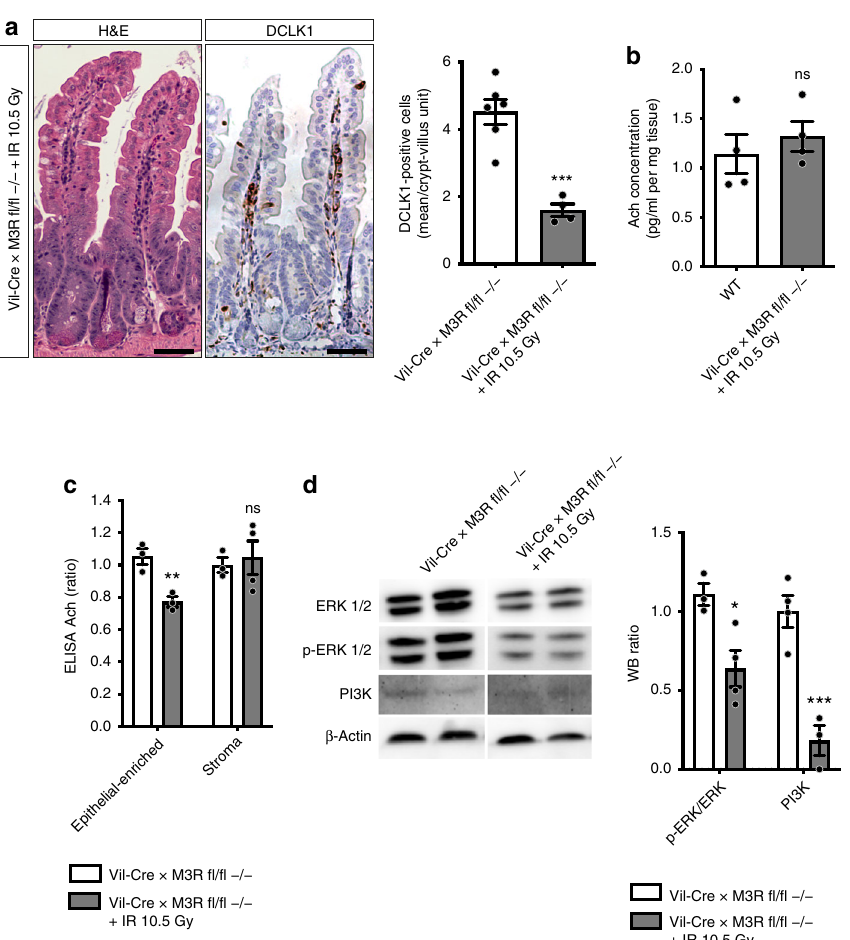
Fig. 6 Acute tissue injury abrogates compensatory tuft cell circuit following epithelial M3R ablation. a H&E and DCLK1 immunostainings 3 days after 10.5 Gy WBI ( n = 6 Vil-Cre × M3R fl / fl − / − mice, Mean = 4.517, SEM = 0.377; n = 4 Vil-Cre× M3R fl / fl − / − + IR 10.5 Gy mice, Mean = 1.6, SEM = 0.185; unpaired two-tailed t test, t = 5.906, df = 8), bar graphs = 100 µ m. b Acetylcholine in Vil-Cre × M3R fl / fl tissues 3 days after 10.5 Gy WBI (ELISA; n = 4 mice/group; WT Mean = 1.14, SEM = 0.2; Vil-Cre × M3R fl / fl − / − + IR 10.5 Gy Mean = 1.321, 0.152; unpaired t test, t = 0.7189, df = 6). c ELISA of epithelial-enriched vs. stroma-enriched Vil-Cre × M3R fl / fl tissues 3 days after 10.5 Gy WBI ( n = 3 Vil-Cre× M3R fl / fl − / − controls epithelial-enriched, stroma; n = 3 Vil-Cre × M3R fl / fl − / − + IR epithelial-enriched, n = 4 Vil-Cre × M3R fl / fl − / − + IR stroma; Vil-Cre × M3R fl / fl − / − control epithelial- enriched Mean = 1.051, SEM = 0.05; stroma Mean = 1, SEM = 0.047; Vil-Cre × M3R fl / fl − / − + IR 10.5 Gy epithelial-enriched Mean = 0.772, SEM = 0.032; stroma Mean = 1.046, SEM = 0.102; multiple t tests, epithelial-enriched t = 4.706, df = 4; stroma t = 0.3609, df = 5). d p-ERK/ERK and PI3K analysis after acute injury (3 days post 10.5 Gy WBI; n = 3 Vil-Cre × M3R fl / fl − / − controls p-ERK/ERK, n = 4 Vil-Cre × M3R fl / fl − / − controls PI3K; n = 4 Vil-Cre × M3R fl / fl − / − + IR p-ERK/ERK, n = 3 Vil-Cre × M3R fl / fl − / − + IR PI3K; Vil-Cre × M3R fl / fl − / − control p-ERK/ERK Mean = 1.109, SEM = 0.07; PI3K Mean = 1, SEM = 0.101; Vil-Cre × M3R fl / fl − / − + IR p-ERK/ERK Mean = 0.637, SEM = 0.115; PI3K Mean = 0.181, SEM = 0.096; ordinary two-way ANOVA, p-ERK/ERK t = 3.236, df = 10; PI3K t = 5.608, df = 10). Source data are provided as a Source Data fi le. * p < 0.05, ** p < 0.01, *** p < 0.005; ns not signi fi